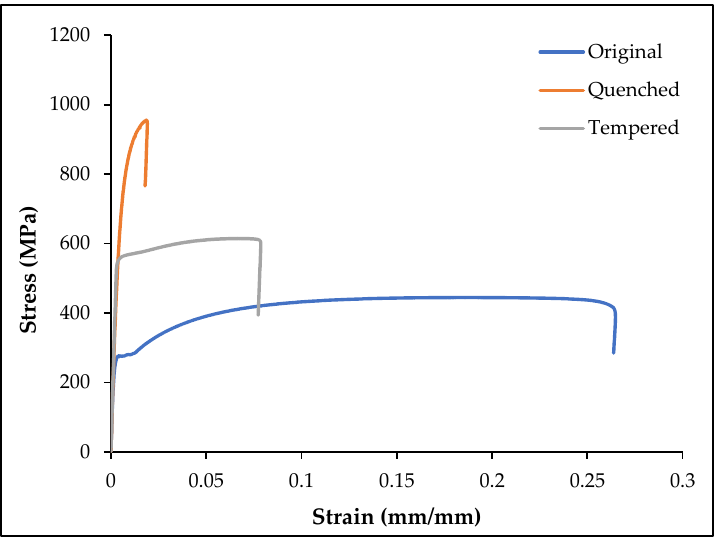
Figure 6. The engineering stress – strain curves for original, quenched, and tempered samples.